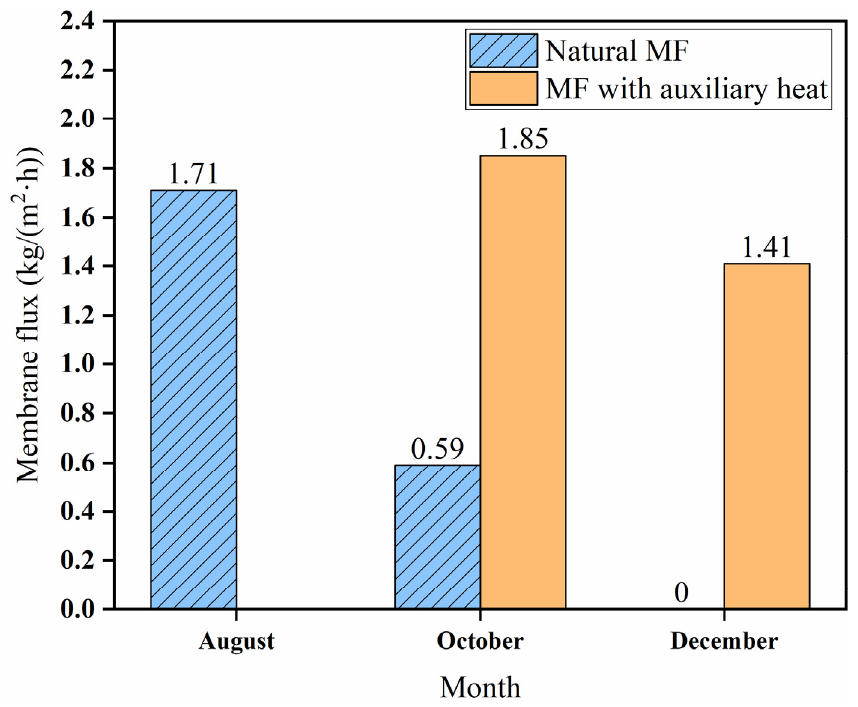
Figure 9. Schematic diagram of the seasonal natural and auxiliary MF.